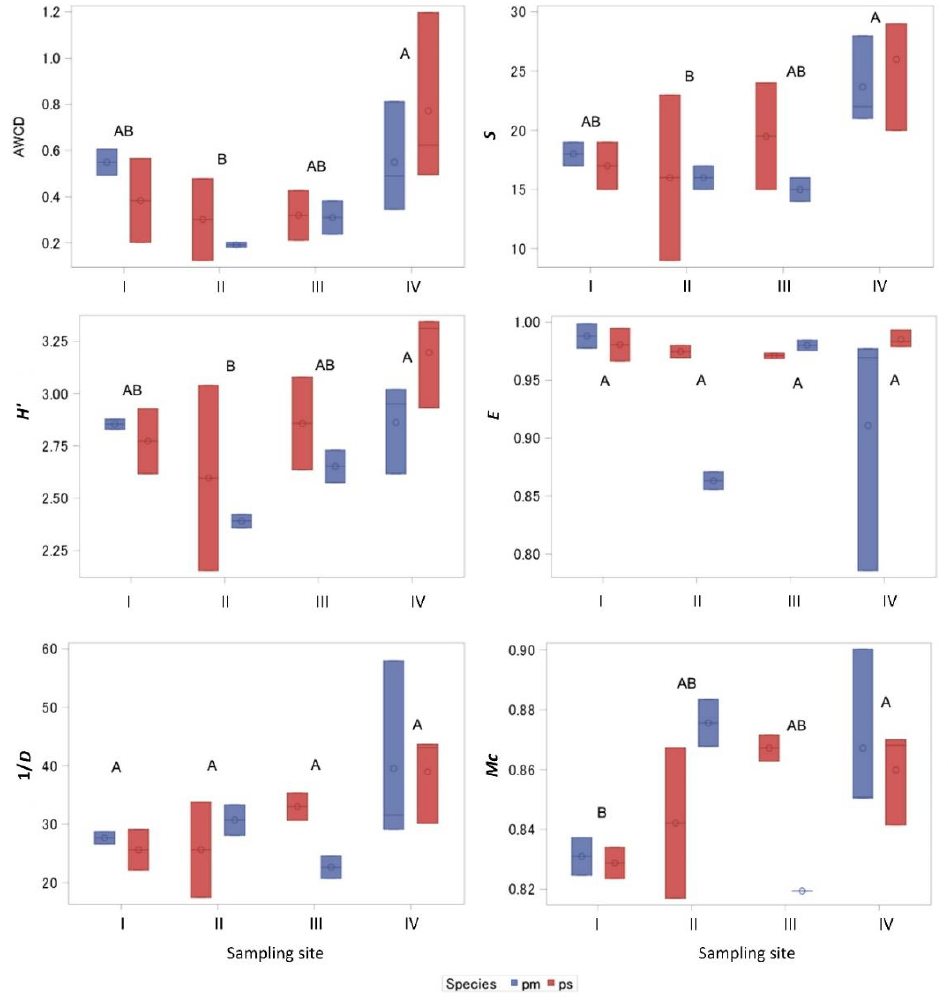
Figure 3. Mean indices ( ± SD) of metabolic activity of microorganisms in mineral soil (at 0–10 cm depth) around Pinus mugo (pm) and Pinus sylvestris (ps) in different stands. AWCD: the average well color development; S : substrate richness; H ’ - Shannon’s diversity index, E : Pielou Evenness; 1/ D : Simpson’s reciprocal diversity index; Mc : McIntosh diversity index. Capital letters show differences between stands, determined via Waller–Duncan K-ratio t test.